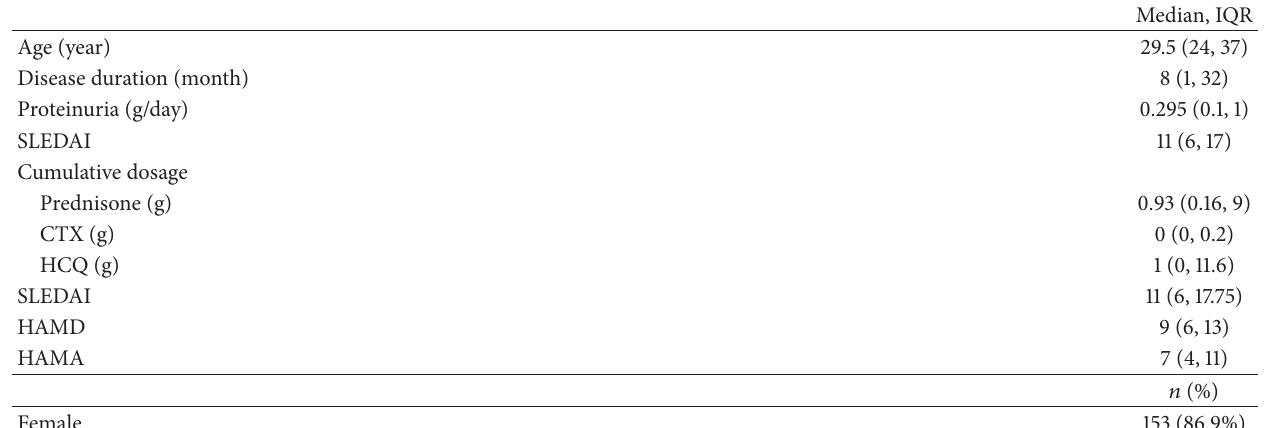
Table 1: General conditions of 176 SLE